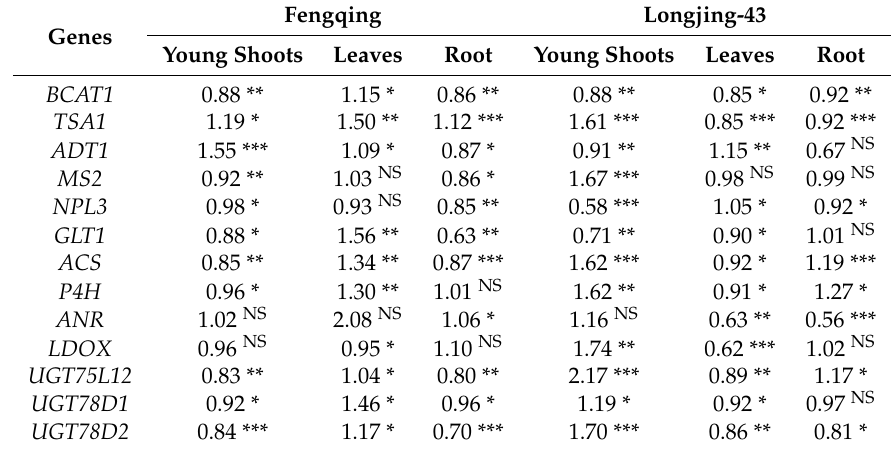
Table 5. qRT-PCR expression of metabolic gene transcripts normalized with reference gene delta-CT ( ∆ C T ) are shown as fold changes (log 2[ − P/+P] ) . Fengqing Longjing-43 Genes Young Shoots Leaves Root Young Shoots Leaves